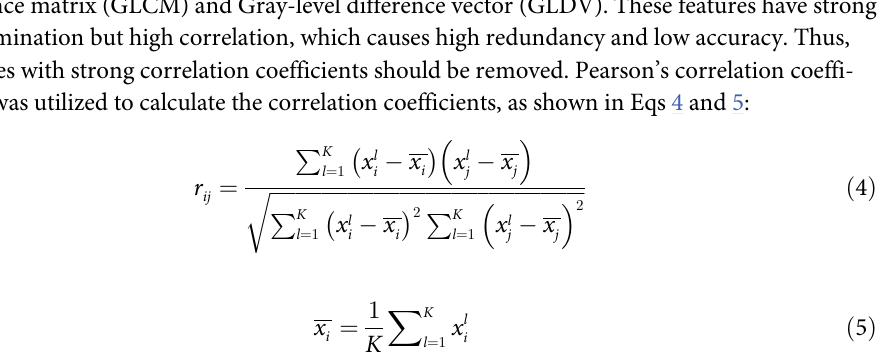
refers to the mean value of the i-th i